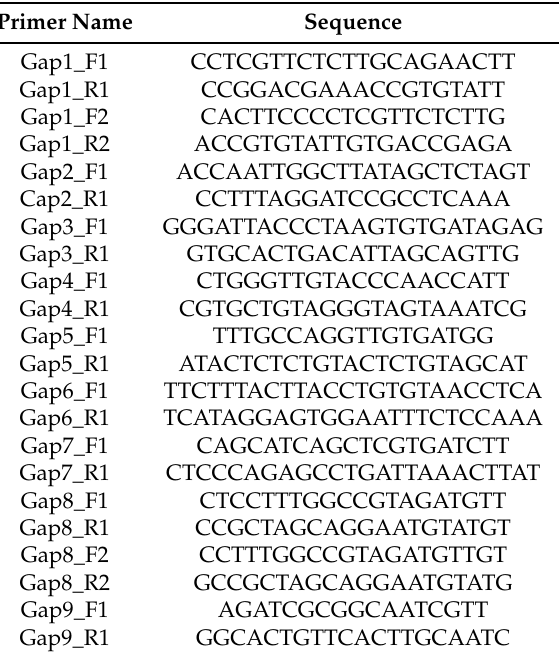
Table 4. Primer sets used for filling sequence